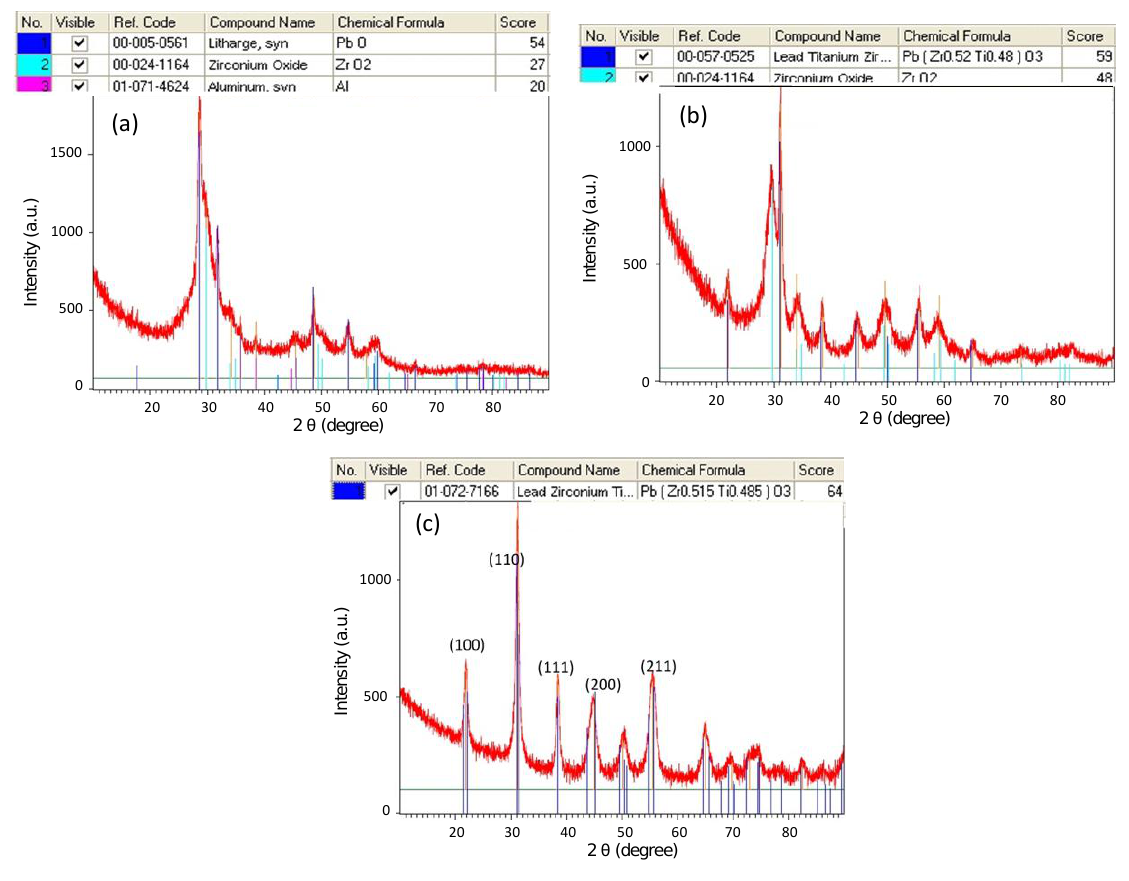
Figure 7. XRD spectra of deposited PZT film for different annealing temperatures: ( a ) 500 °C; ( b ) 525 °C; ( c ) 600